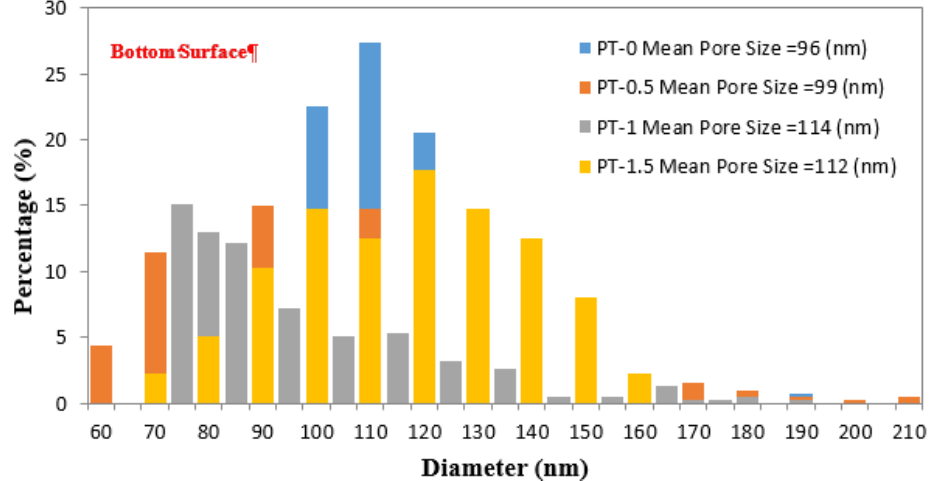
Figure 8. Pore size distribution of the ( top) and ( bottom) surfaces of the PVC membranes at different TiO 2 amounts: (PT-0) 0 gm TiO 2 ; (PT-0.5) 0.5 gm TiO 2 ; (PT-1) 1 gm TiO 2 ; and (PT-1.5) 1.5 gm TiO 2 .